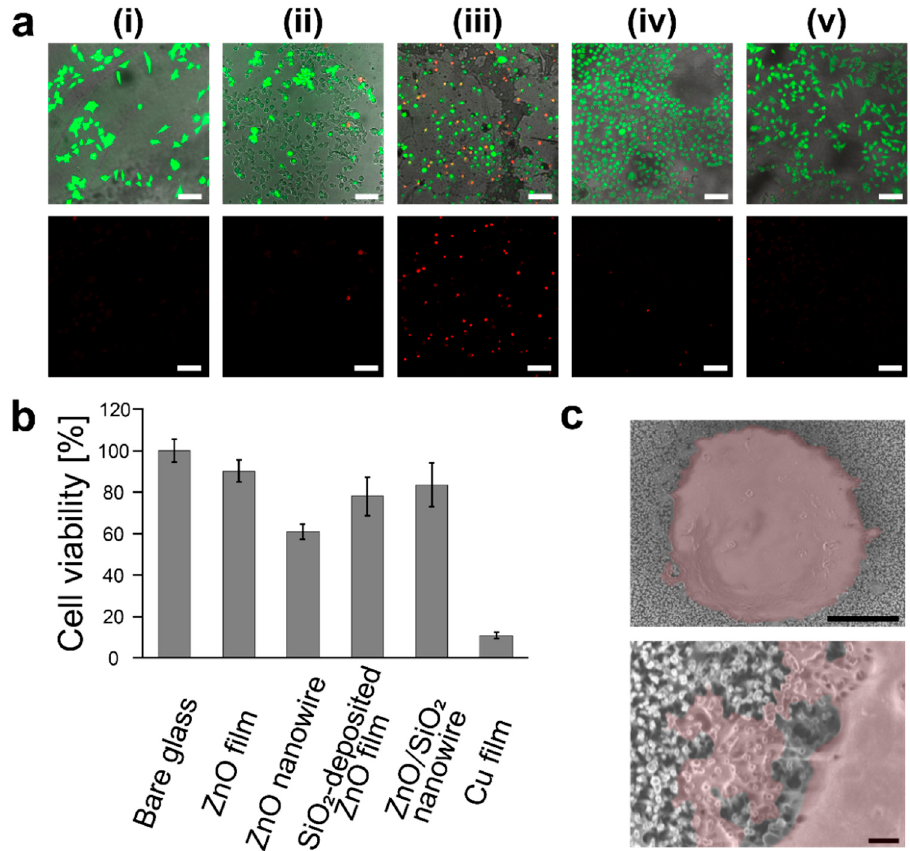
Figure 4. ( a ) Fluorescence images of HeLa cells cultured on various substrates: (i) bare glass, (ii) ZnO film, (iii) ZnO nanowires, (iv) SiO 2 -deposited ZnO film, (v) ZnO / SiO 2 nanowires (upper, merged images of cells stained by calcein-acetoxymethyl (AM) and PI (propidium iodide); lower, fluorescence images of cells stained by PI; scale bars, 100 µ m). ( b ) Cell viability of HeLa cells cultured on each substrate. These viabilities were measured by using flow cytometry and viability of the cells on bare glass substrate was defined as 100%. ( c ) SEM images of HeLa cells cultured on ZnO / SiO 2 nanowire substrate (scale bars, 5 µ m (upper) and 500 nm (lower)).